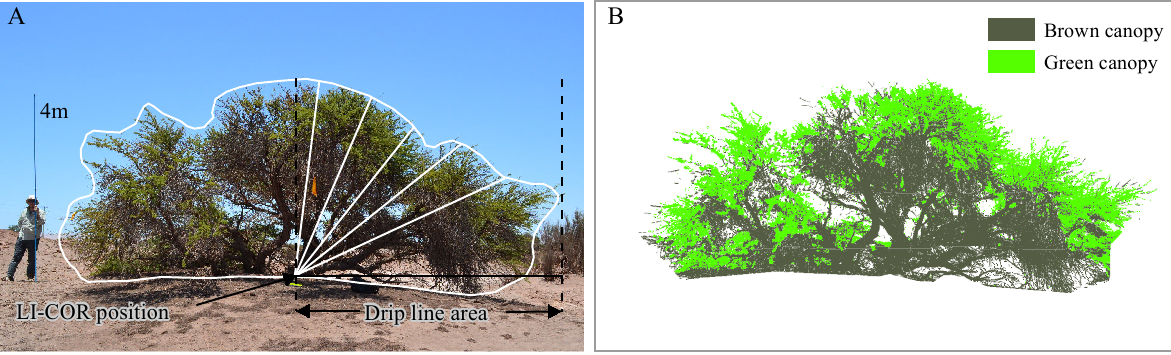
Figure 3. ( A ) Procedure for measuring DLLAI of a Tamarugo tree using the LI-COR instrument. Path lengths at the five viewing angles of the instrument were corrected by the